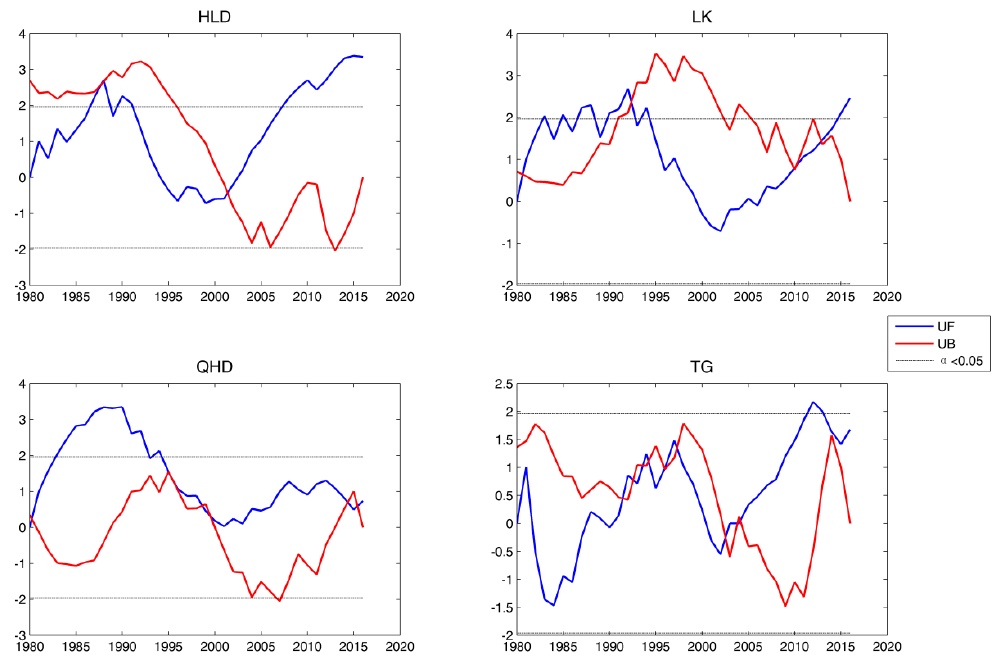
Figure 11. The MK-values ( y axes) for sequential Mann–Kendall test against time (year, x axes) for 99.9% extreme sea level at four tide gauges; the blue line represents the progressive series UF ( t ), the red line represent retrograde series UB ( t ), and the dotted lines are the confidence limits ( α = 0.05).